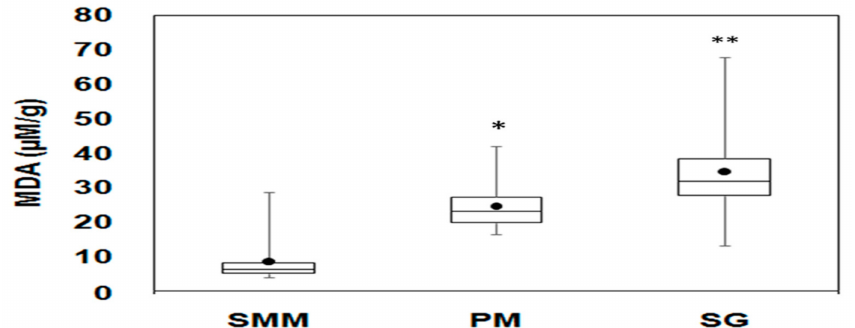
Figure 2. Boxplot with median and mean ( • solid circles) of LPO (as MDA concentration) in U. laete- virens from the VL: SMM—Santa Maria del Mare; PM—Porto Marghera; SG—San Giuliano. *, ** de- note significant difference ( p < 0.05, p < 0.01, respectively) between sampling